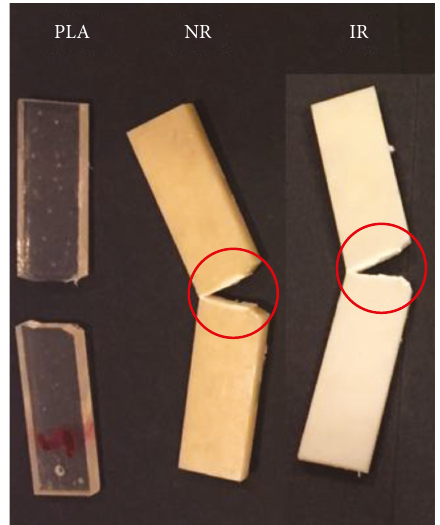
Figure 9: The fractured specimens after the notched Izod impact tests.